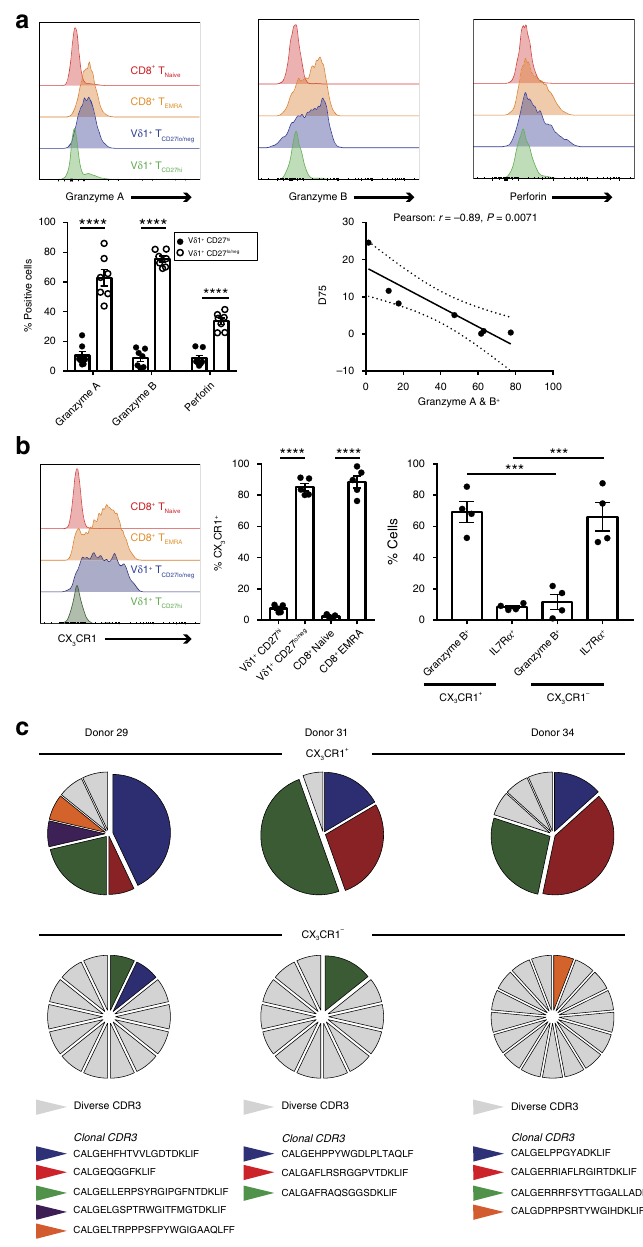
Figure 7 | Clonally expanded CD27 lo/neg V d 1 þ Tcells express CX 3 CR1 and cytotoxic effector molecules. ( a ) Expression of intracellular cytotoxic effector molecules, granzyme A, granzyme B and perforin by CD8 þ T Naı¨ve , CD8 þ T EMRA , V d 1 þ CD27 lo/neg and V d 1 þ CD27 hi cells. Correlation graph between all 7 donors and the corresponding TCR d D75 calculated from TCR repertoire deep sequencing. Representative histograms, graph and dot plot are from 7 donors. ( b ) Expression of CX 3 CR1 on the surface of CD8 þ T Naı¨ve , CD8 þ T EMRA , V d 1 þ CD27 lo/neg and V d 1 þ CD27 hi cells. Within CX 3 CR1 þ or CX 3 CR1- V d 1 þ Tcells the expression of granzyme B and IL7R a . Representative histograms of 5 donors (left), with all 5 donors shown (middle) and 4 of these donors assessed for CX 3 CR1/granzyme B/IL7R a (right). ( c ) Single cell gd TCR analysis from 3 donors, single cells were sorted from CX 3 CR1 þ or CX 3 CR1- V d 1 þ T cells and CDR3 sequences analysed against dominant clonotypes identified by deep sequencing. Graphs show the mean ± s.e.m. and data were analysed by two-way ANOVA ( a ) and one-way ANOVA with Holm-Sidak’s post-tests ( b ), *** P o 0.001 and **** P o